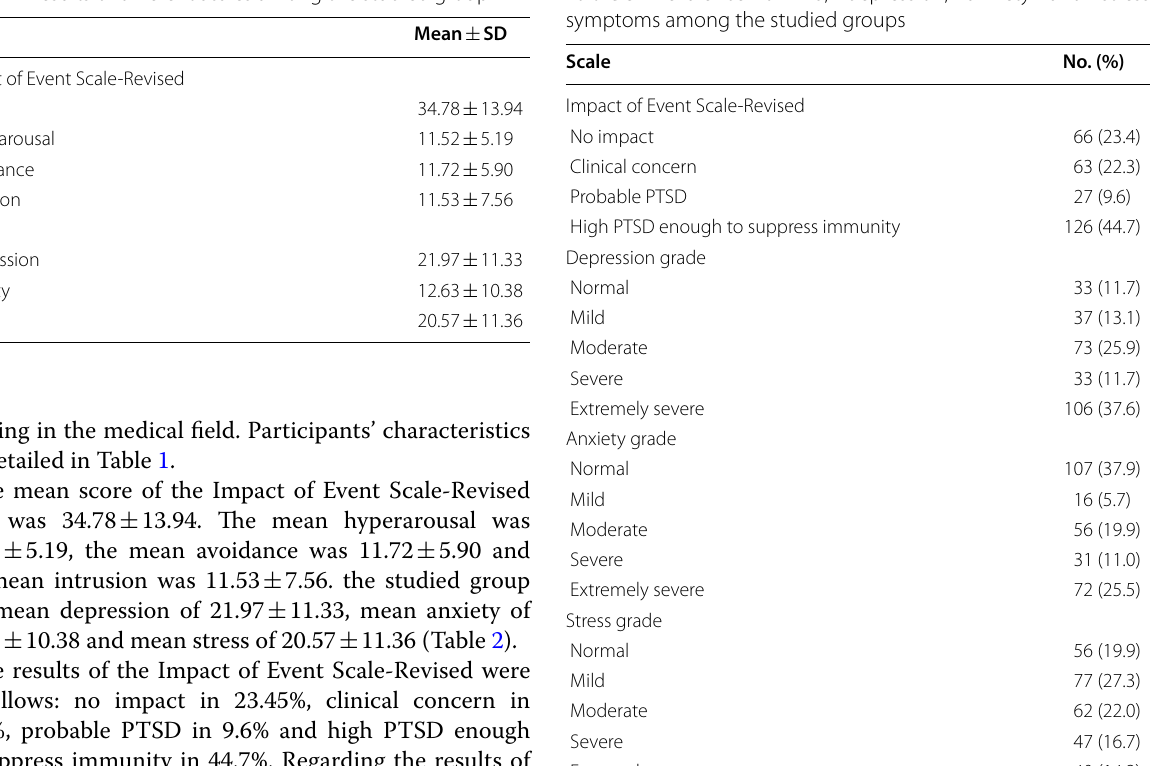
The multivariate regression analysis of the significant univariate factors revealed that IES remained signifi- cantly associated with gender and previous road acci- dents ( p 0.015 and 0.017, respectively), depression and anxiety remained significantly associated with personal history of psychiatric illness ( p 0.001 for each) while